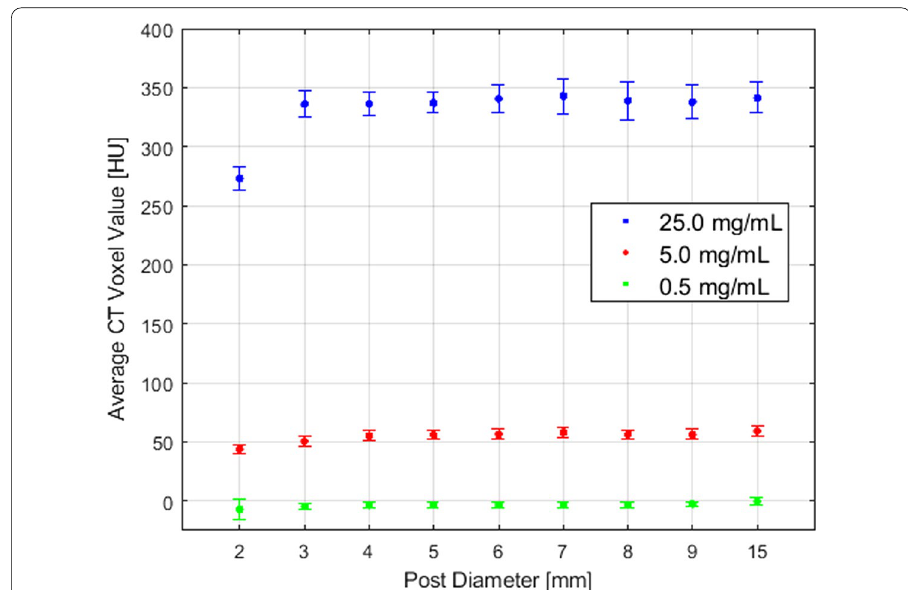
Fig. 3 The average CT voxel value within post structures as a function of post diameter for the three microsphere concentrations within the CT calibration phantom: 0.5 mg/mL, 5.0 mg/mL, and 25.0 mg/mL. Error bars represent the standard deviation of the voxel values within a post